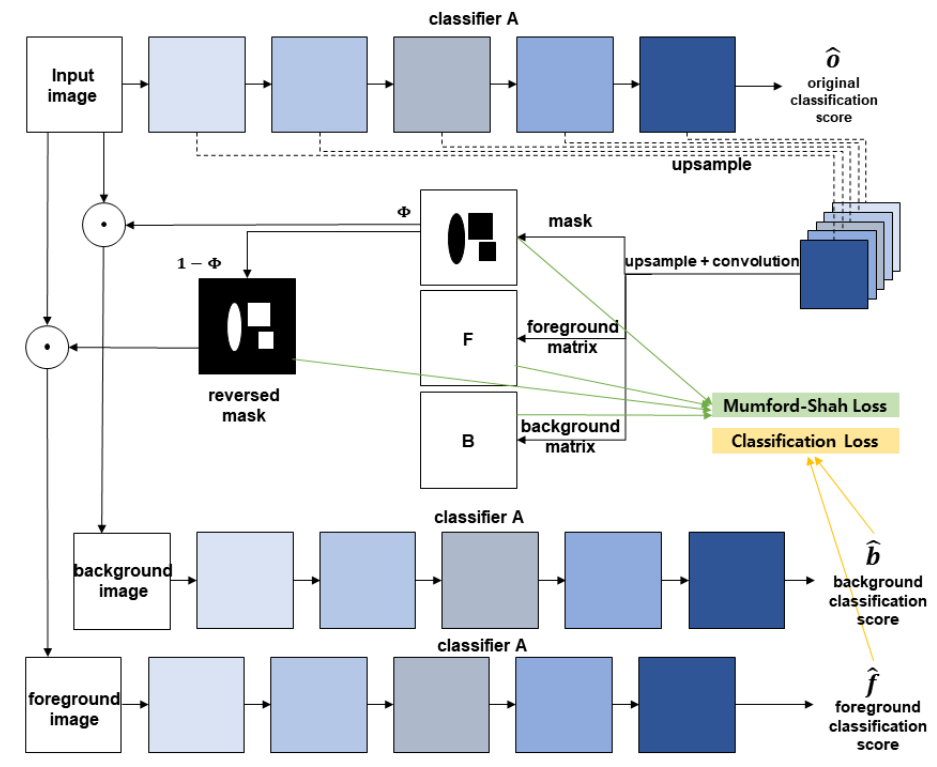
Figure 2. Illustration of the second network when the loss is composed of piecewise-smooth Mumford–Shah energy